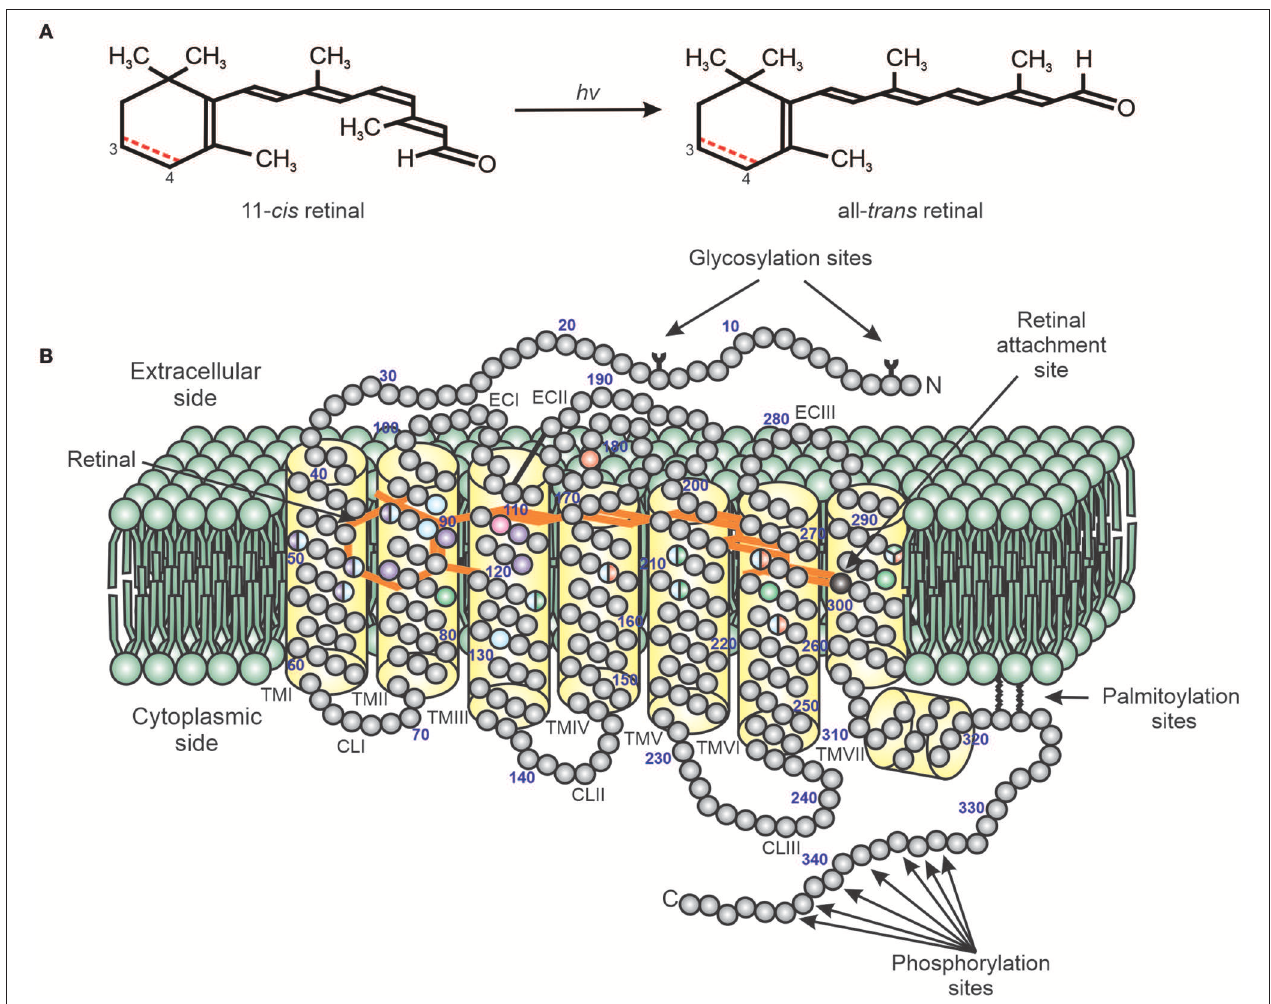
FIGURE 2 | A diagram of the structure of a typical vertebrate photopigment (Modified from Davies et al., 2012). (A) The initial step in phototransduction consists of photon ( hv ) absorption by 11- cis retinal, which photoconverts to all- trans retinal. Vertebrate photopigments are broadly divided into rhodopsins that utilize a vitamin A 1 -derived chromophore (black line) or porphyropsins that contain a vitamin A 2 -derived chromophore (3,4-didehydroretinal). In the latter case, the presence of a double (C = C) bond between C 3 and C 4 is shown as a dotted red line. (B) Side view of photopigment (opsin and retinal chromophore), showing the presence of seven transmembrane domains (yellow), archetypal of the GPCR superfamily, and their arrangement around the retinal chromophore (orange) (modified from Davies et al., 2012 ). The retinal attachment site (Lys296, black) and counterion (Glu113, pink) to the Schiff base are shown. Opsin residues that cluster either around the Schiff base or ionone ring of the retinal chromophore are colored to highlight the amino acids involved in the spectral tuning of LWS (red), SWS1 (violet), SWS2 (blue), and RH2/RH1 (green) photopigments. Residues important for stabilizing the tertiary structure [e.g., disulphide bridge, amino-terminal (N) glycosylation sites] and the activation/deactivation of photopigments [e.g., carboxyl-terminal (C) phosphorylation sites], as well as membrane anchorage (e.g., palmitoylation sites), are also shown. TM, transmembrane; CL, cytoplasmic loop; EC, extracellular loop. The numbering is based on the bovine rod opsin (RH1)